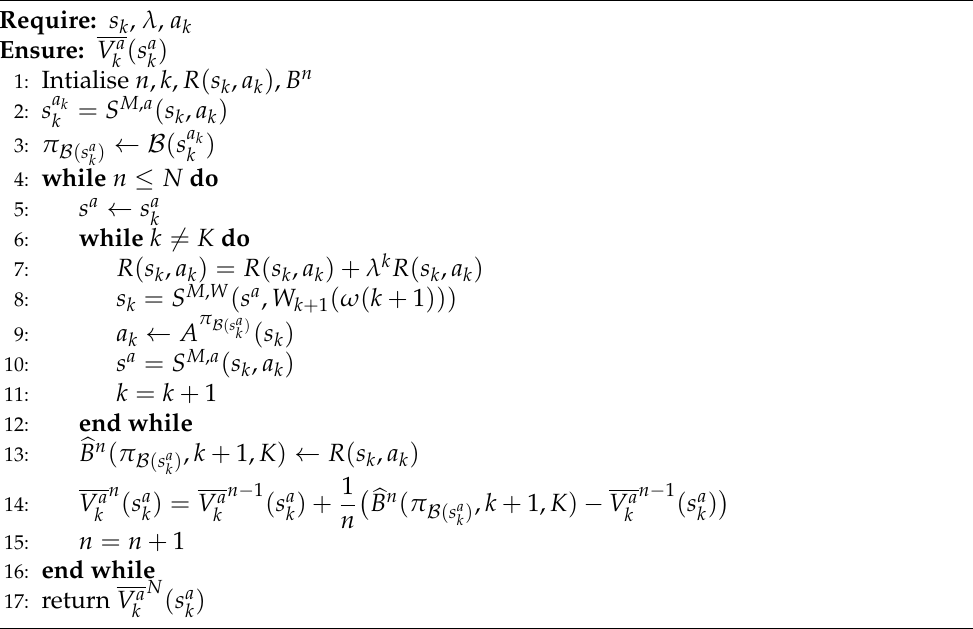
( s a ) (as shown in [8] based on PDS-RA proposed by k k